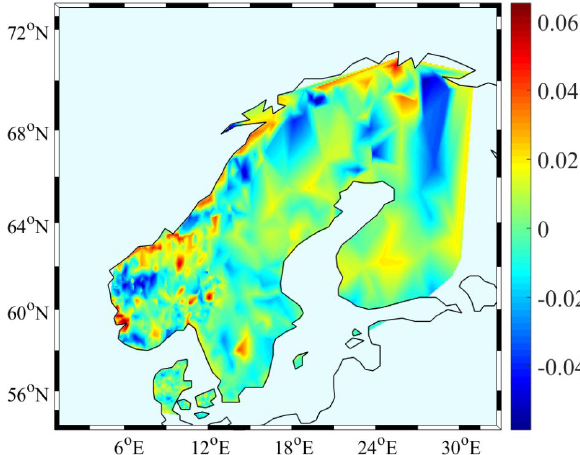
Fig. 3. Residuals after least-squares detrending in each country, based on the selected corrective surface models and the filtered discrepancies with CIs of 95% in Sweden and Norway and nonfil- tered one in Denmark and